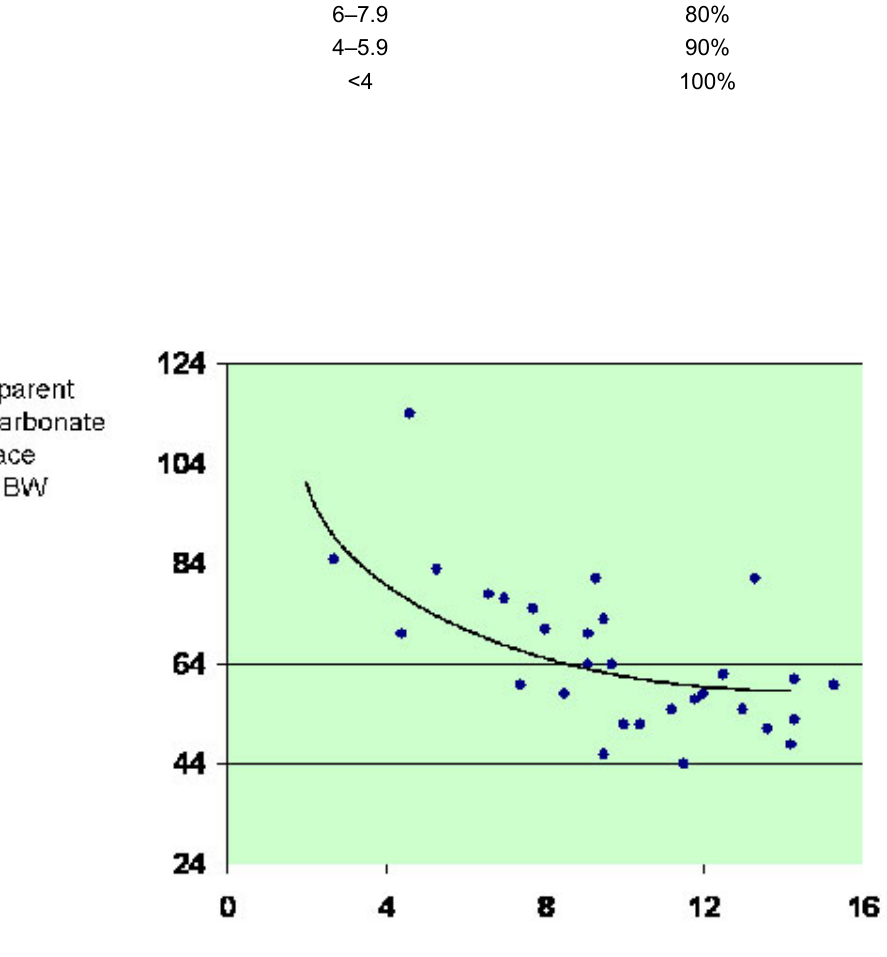
FIGURE 1. Fig 1. Initial bicarbonate concentration in